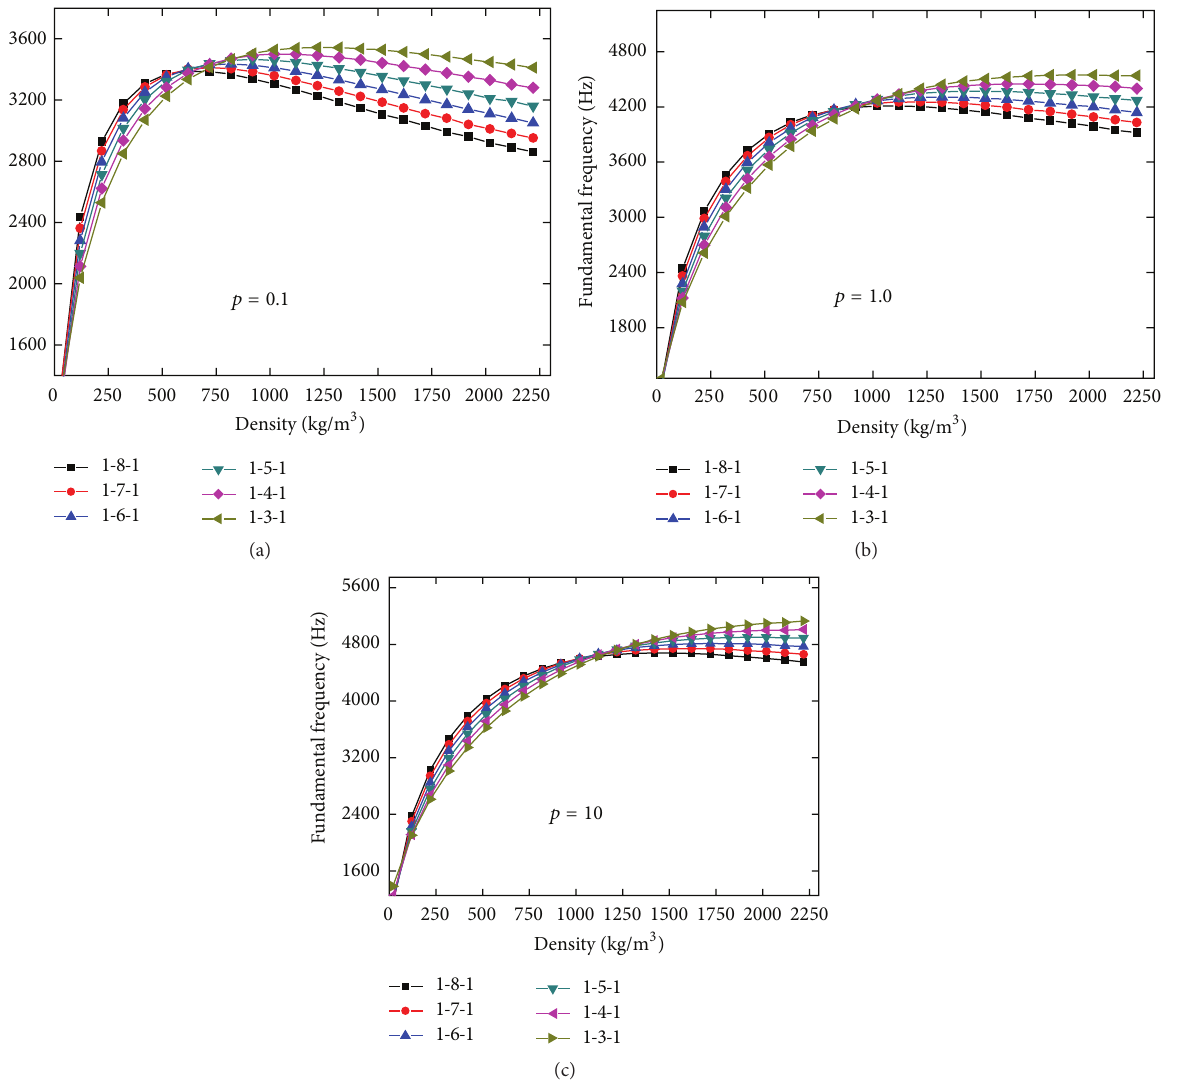
Figure 3: Fundamental frequency of the sandwich beams with different thickness ratios ( 𝑡 𝑓 /𝑡 𝑐 /𝑡 𝑓 ) versus density of the core for different gradient exponents. (a) 𝑝 = 0.1 ; (b) 𝑝 = 1.0 ; (c) 𝑝 = 10